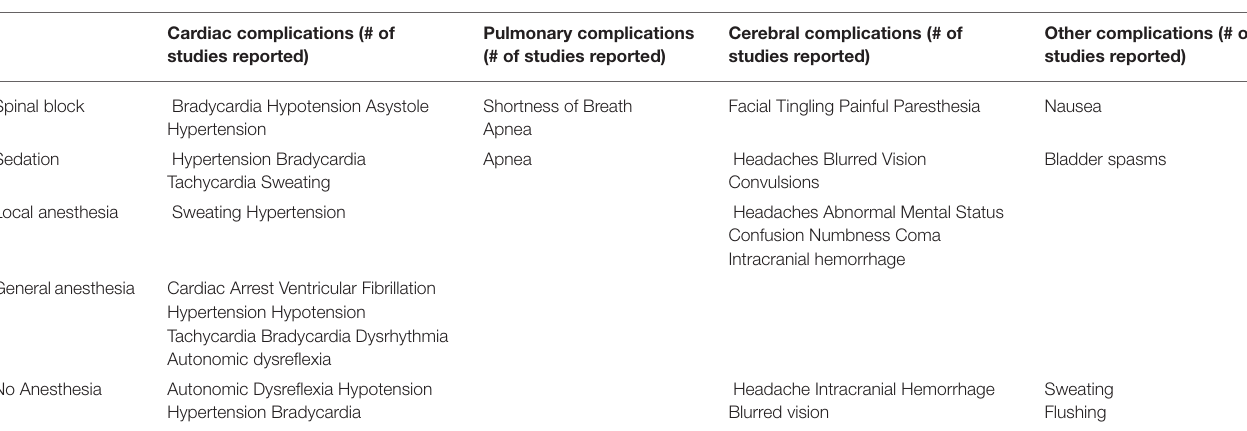
Pulmonary complications (# of studies reported)